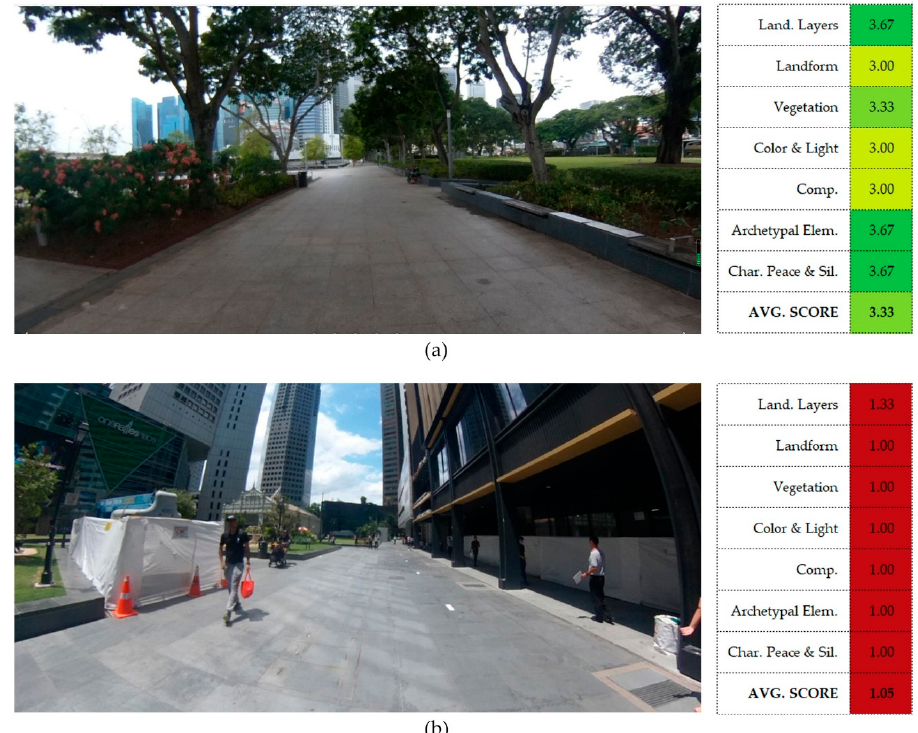
Figure 5. The highest and the lowest CL scoring scenes of all set with total CL scores and scores for each category, averaged across three experts: ( a ) scene 1 · 10 · 1 from Path 1–Esplanade Park , with total CL score of 3.33 points and ( b ) scene 4 · 18 · 1 from Path 4–Ra ffl es Place Park , with CL score of 1.05